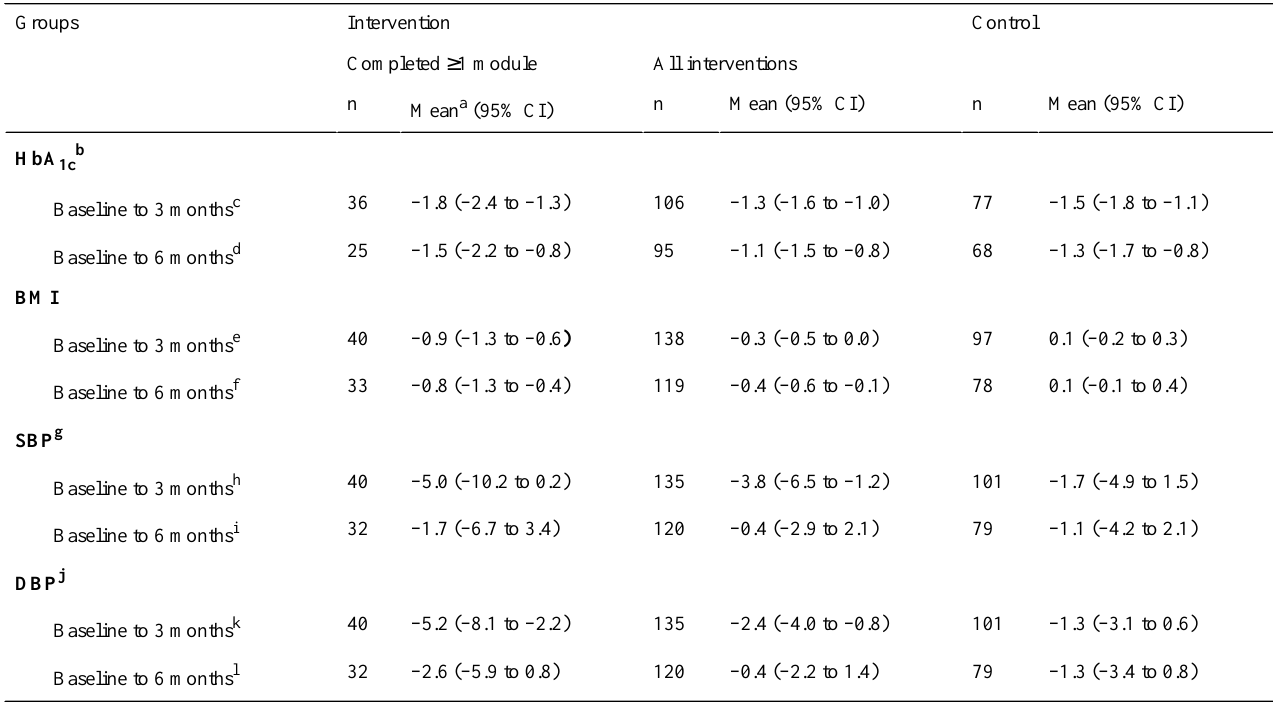
Table 6. Comparison between groups of change in glycated hemoglobin, BMI, and blood pressure from baseline to 3 and 6 months.